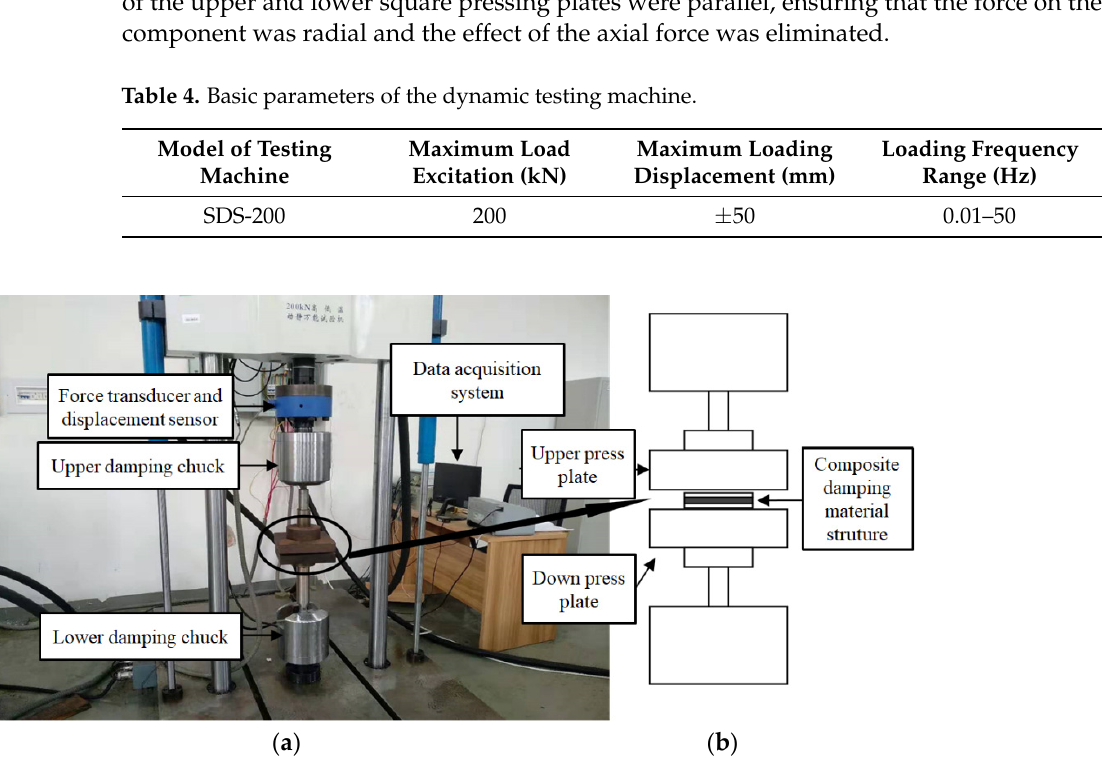
Figure 7. Dynamic testing system: ( a ) Testing system; ( b ) Testing equipment principle.